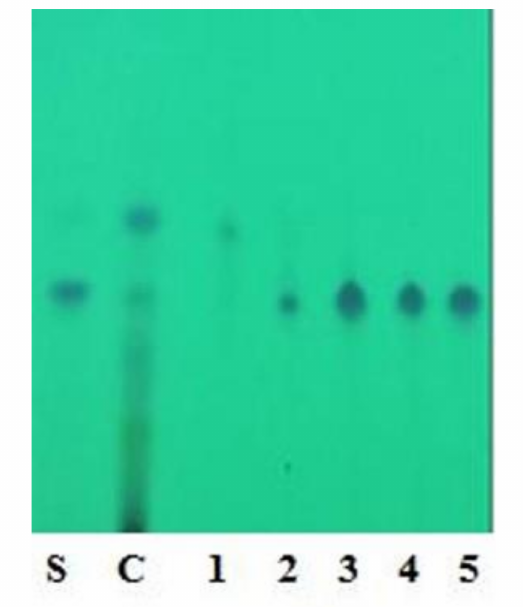
Figure 1. TLC analysis of column fractions. (S: Standard Oxyresveratrol; C: Crude EMK extract; 1–5: fractions collected).